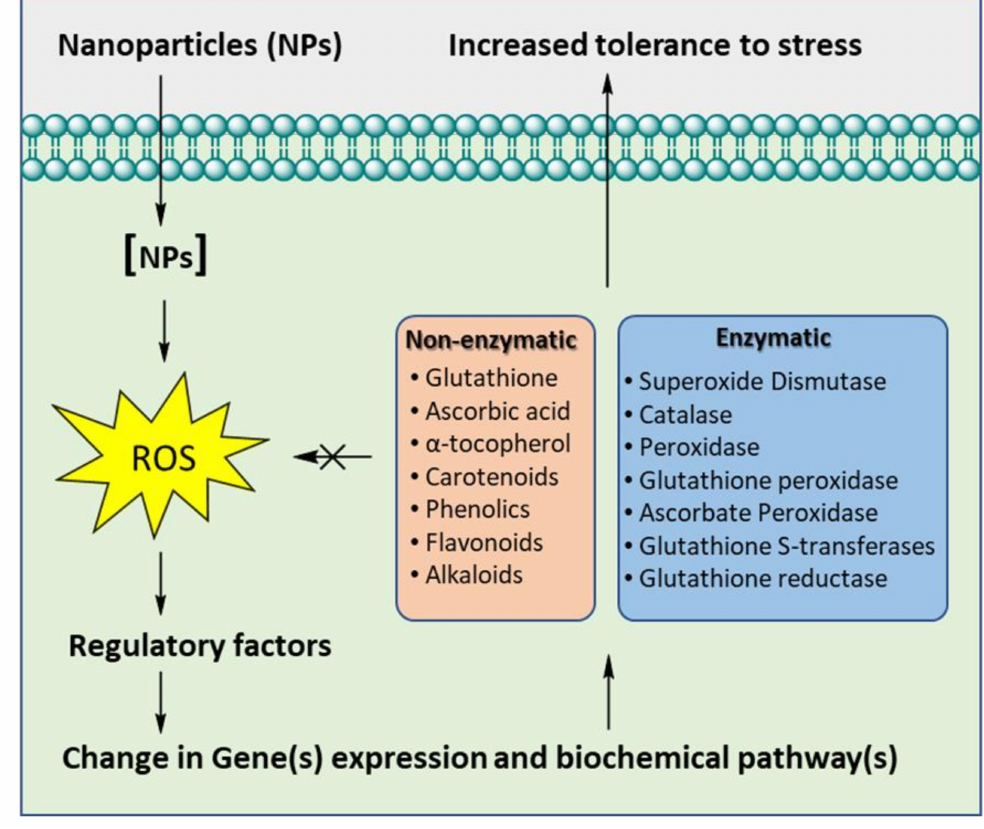
Figure 2. Schematic representation of elicitation of the enzymatic and non-enzymatic antioxidant defense mechanisms of plants by